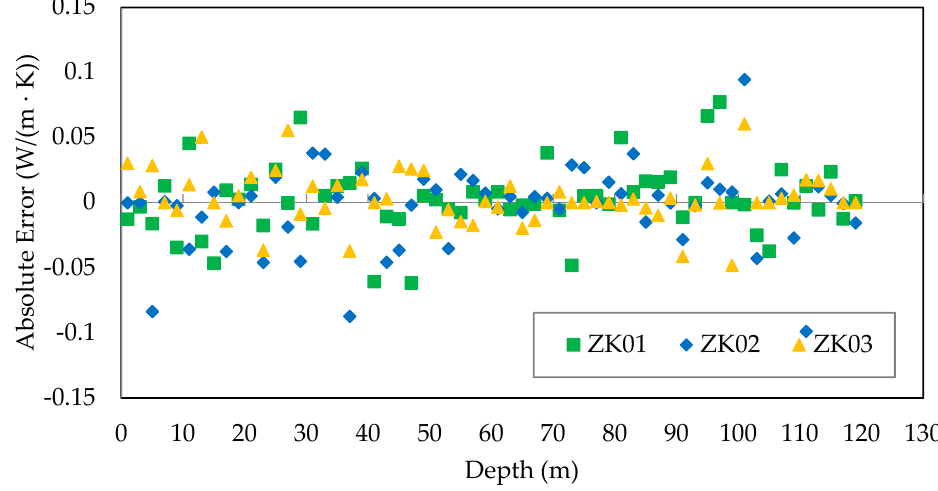
Figure 12. Absolute error of training results of ANN models.